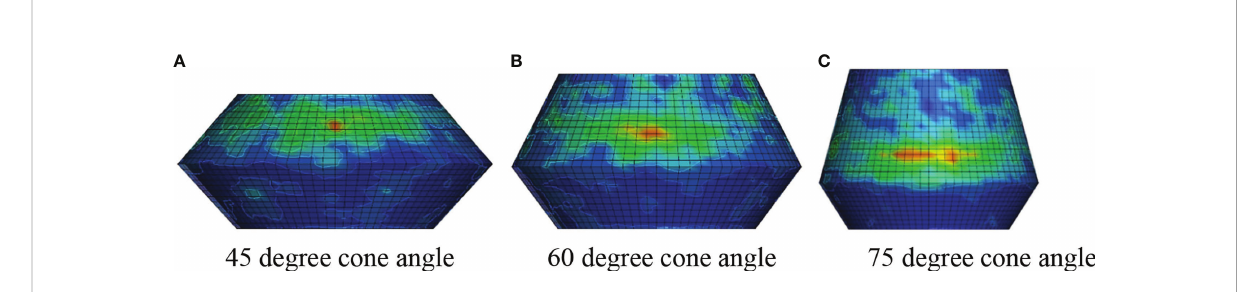
FIGURE 15 Conical structure Von-Mises effective stress distribution. (A) 45° cone angle (B) 60° cone angle (C) 75° cone